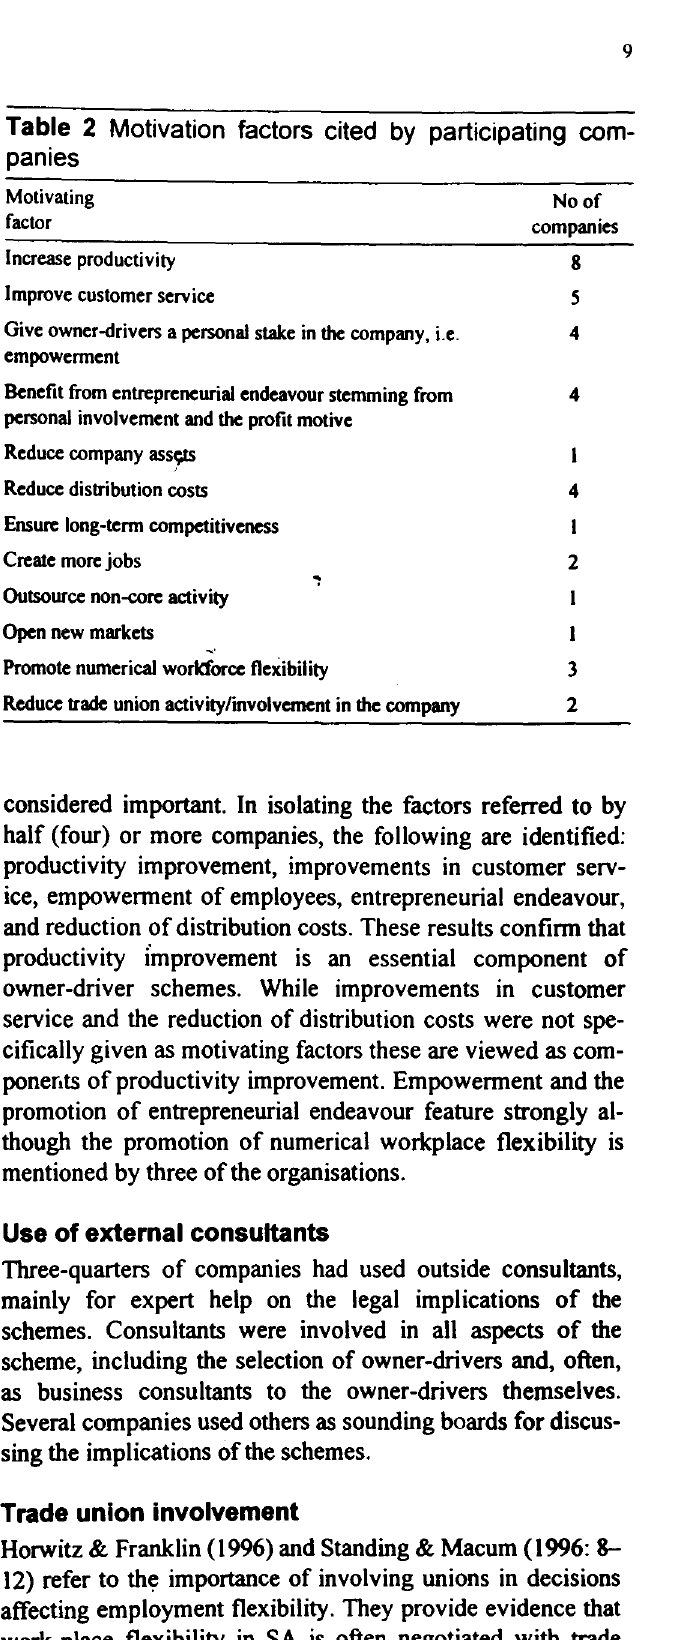
Table 1 Industry sectors of participating companies